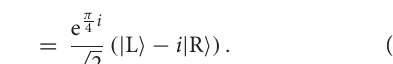
FIGURE 14 | Anti-diagonal vortex generated from the gear of N 1 is π/ 2 ahead of the phase of the input 2. The mode profile of a vortex is obtained at z horizontal electric field E x . (C) The amplitude